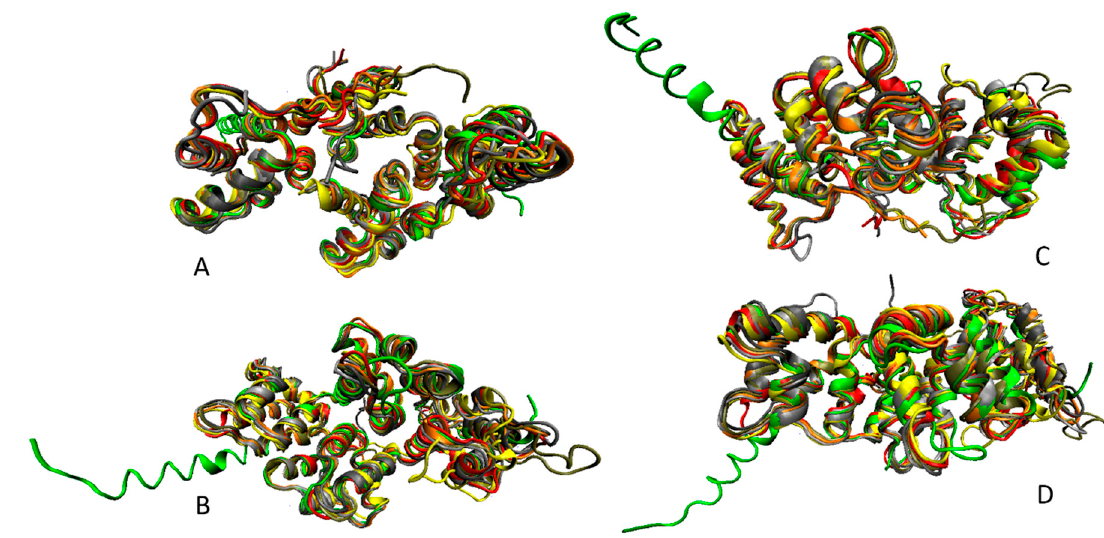
Figure 3. Multiple structural alignment of human annexins (ANXA2, PDB ID: 1W7B, red structure;